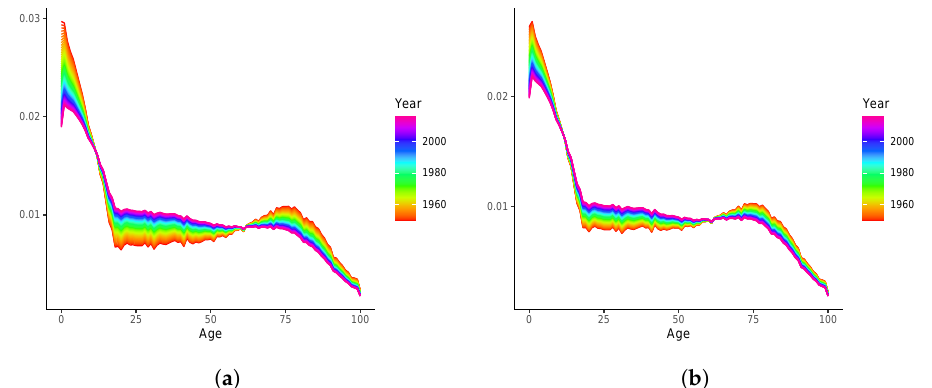
Figure 3. Fitted age-specific declines ˆ b x , t of the averaged population, 1950–2019: ( a ) Epanechnikov kernel; ( b ) Gaussian